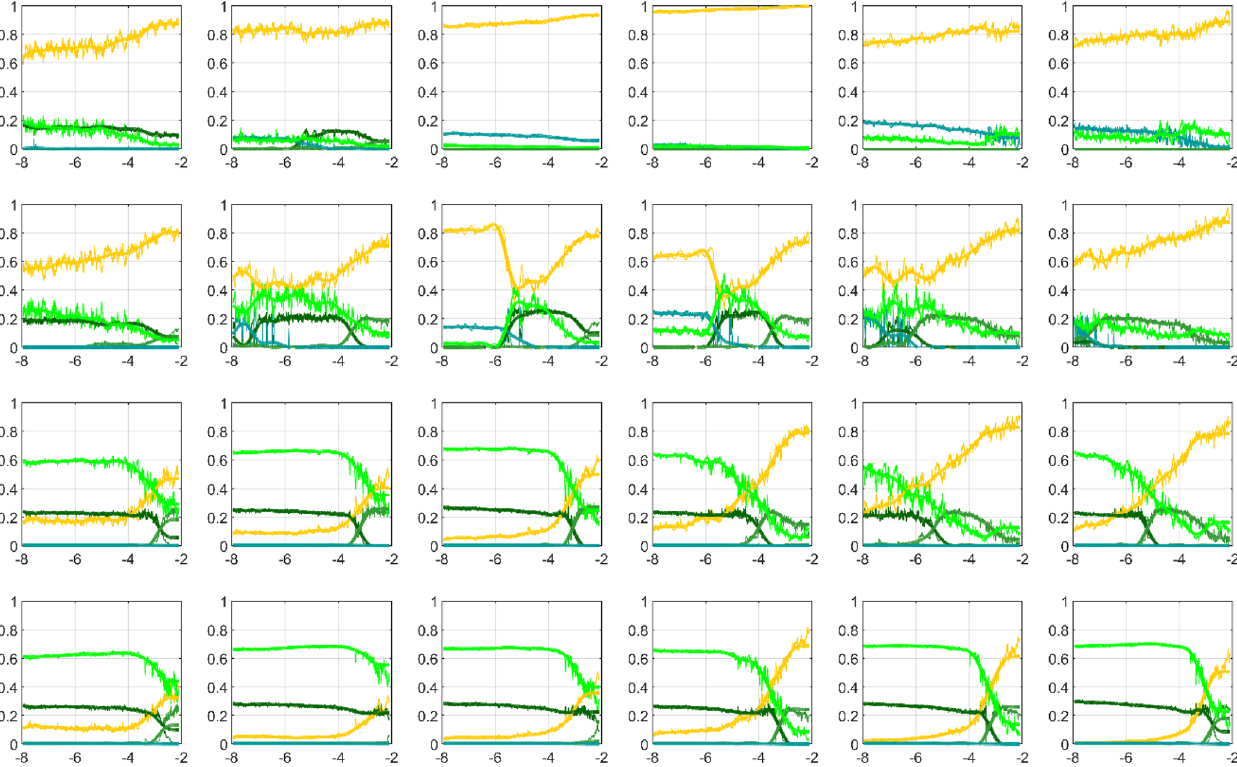
Figure 14. Simulated changes in PFTs in the today Sahara–Sahel region (part of region 3 in Fig. 12). The box in the upper left corner is centred at 25.18 ◦ N, 15 ◦ W, and the box in the lower right corner is at 19.59 ◦ N, 5.63 ◦ W. Like in Fig. 13, the fractional coverage V of PFTs in each grid cell is depicted as function of time, given as kyrb2k. The colours refer to bare soil fraction (yellow), grass (light green), tropical evergreen trees (dark green), tropical deciduous trees (green) and shrubs